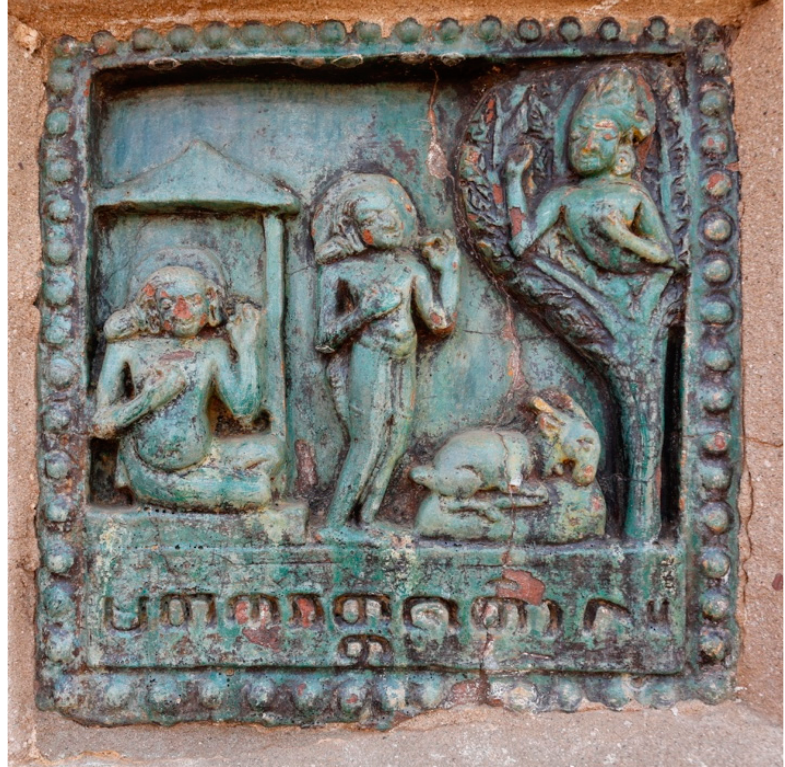
Figure 40. Pagan, Ananda, 11th century. Matakabhatta J ā taka, 18.